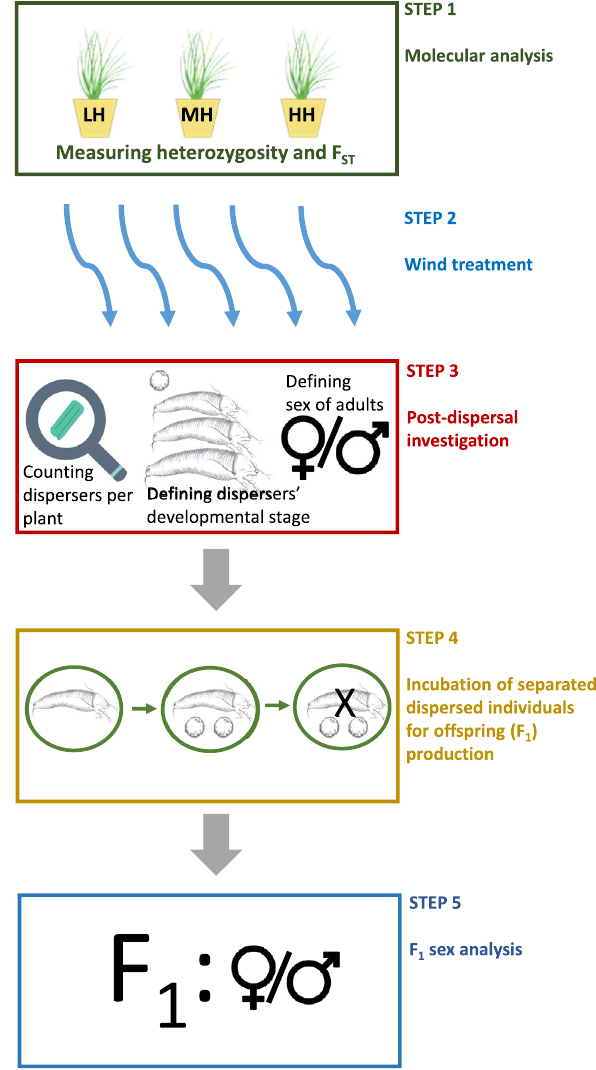
Figure 6. Scheme of the experimental approach.